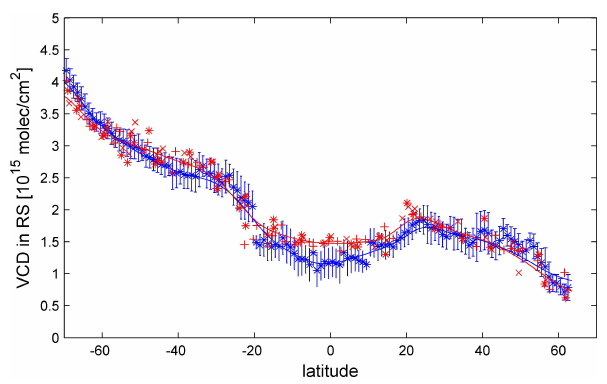
Fig. 3. Latitudinal dependencies of V ∗ (blue) and L RS (red). Nadir RS measurements are binned in 1 ◦ bins and displayed as mean (*) and standard deviation (bar). Limb measurements are displayed for Jan- uary 27 (+), 28 (*), and 29 (x), 2006. The curves show the smoothed LUTs b V RS (d,3) (blue) and b L RS (d,3)